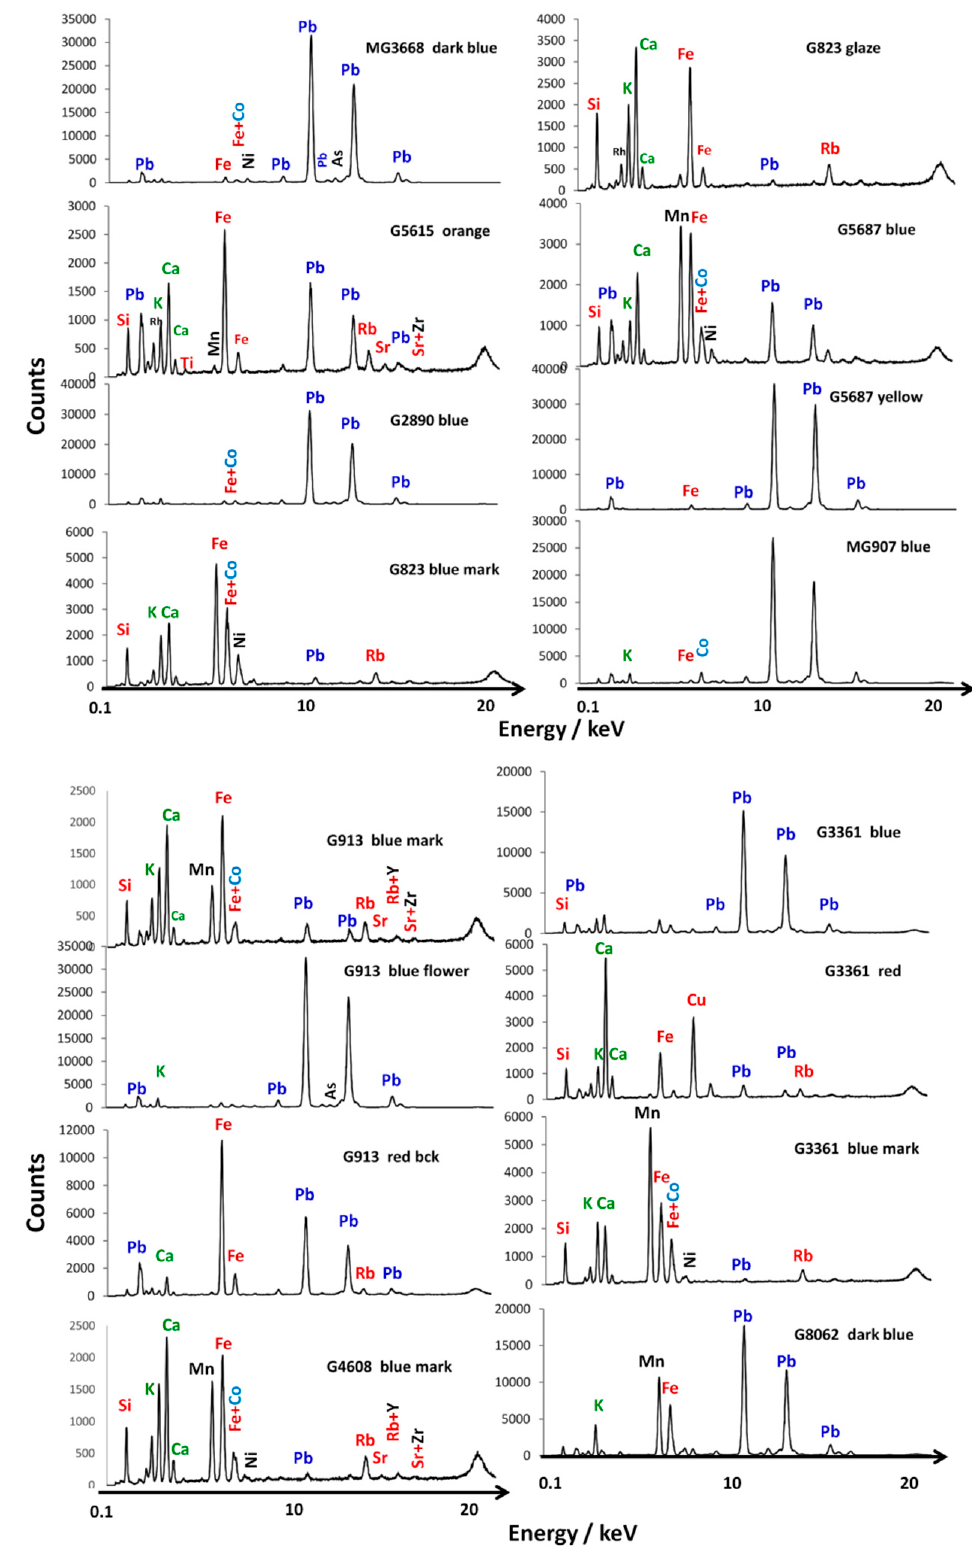
Figure 3. Representative XRF spectra of enameled porcelain (see Table 1 for details).